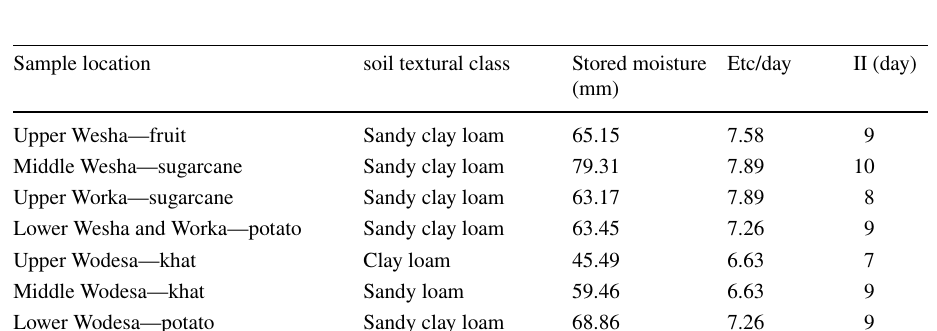
Table 6 Average irrigation interval based on soil moisture content